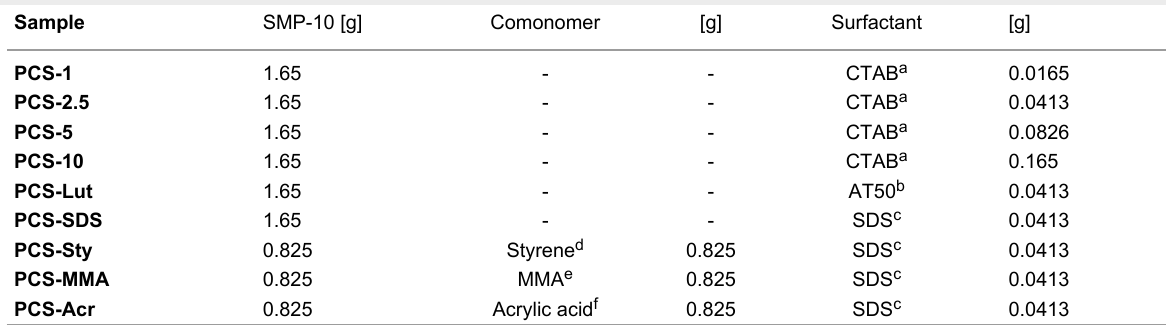
Table 1: List of polycarbosilane nanospheres prepared by the miniemulsion technique.